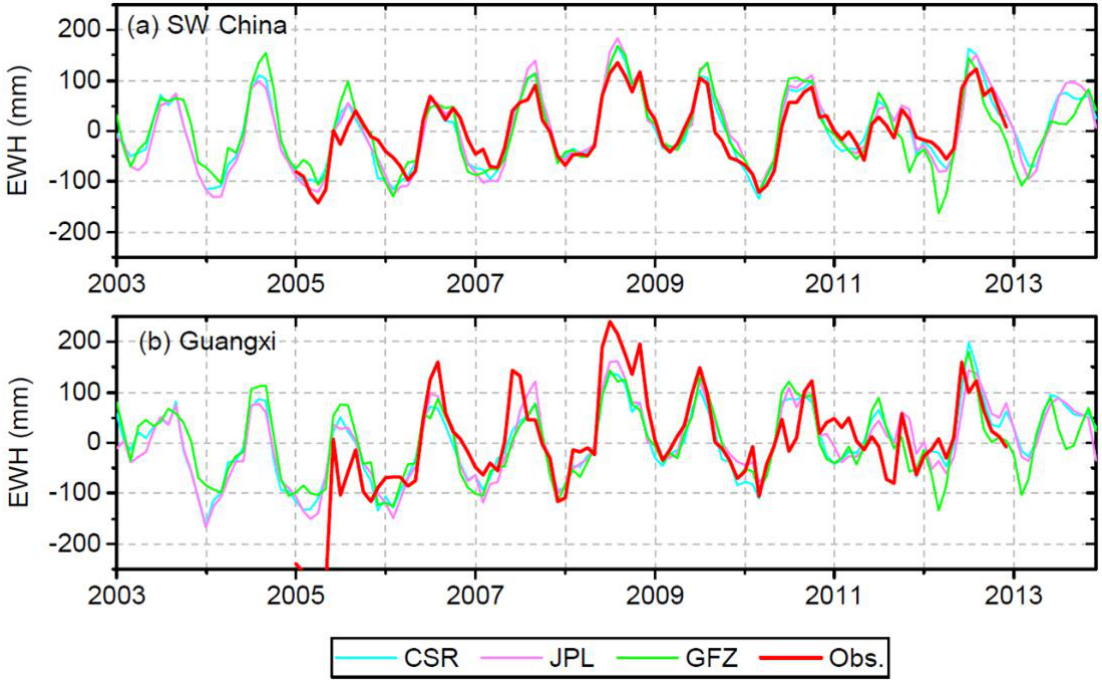
Figure 4. Comparison of uncorrected GRACE TWS from CSR, JPL and GFZ (level-2 SH solutions) with in situ observations of TWS.